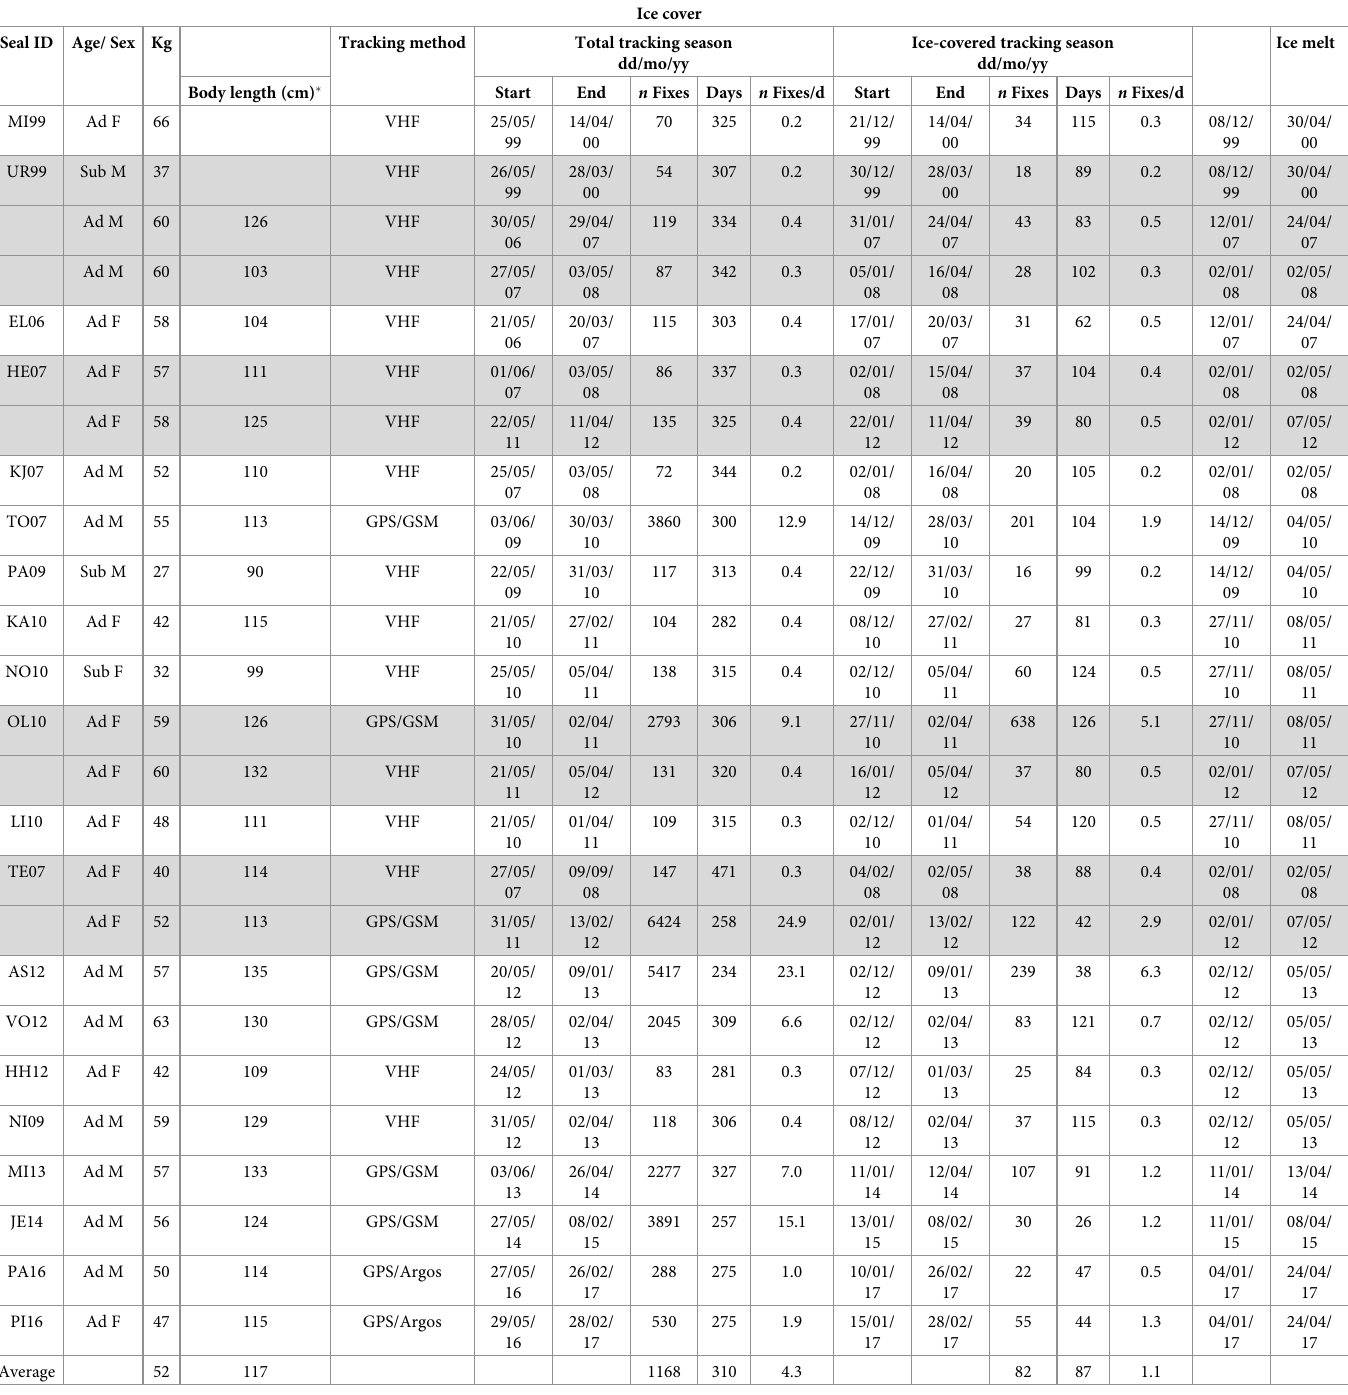
Table 1. Description of the tagged Saimaa ringed